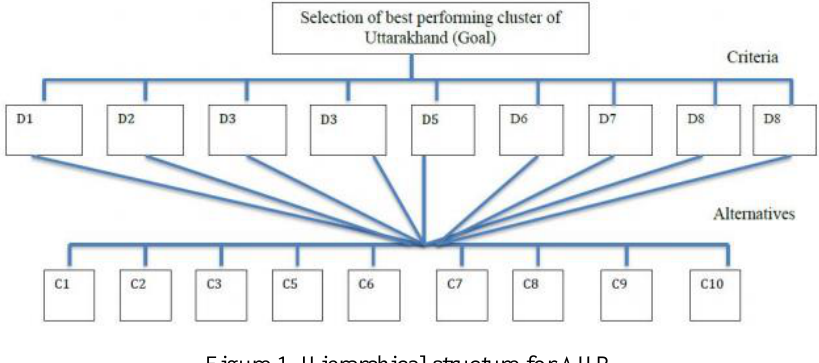
Figure 1. Hierarchical structure for AHP